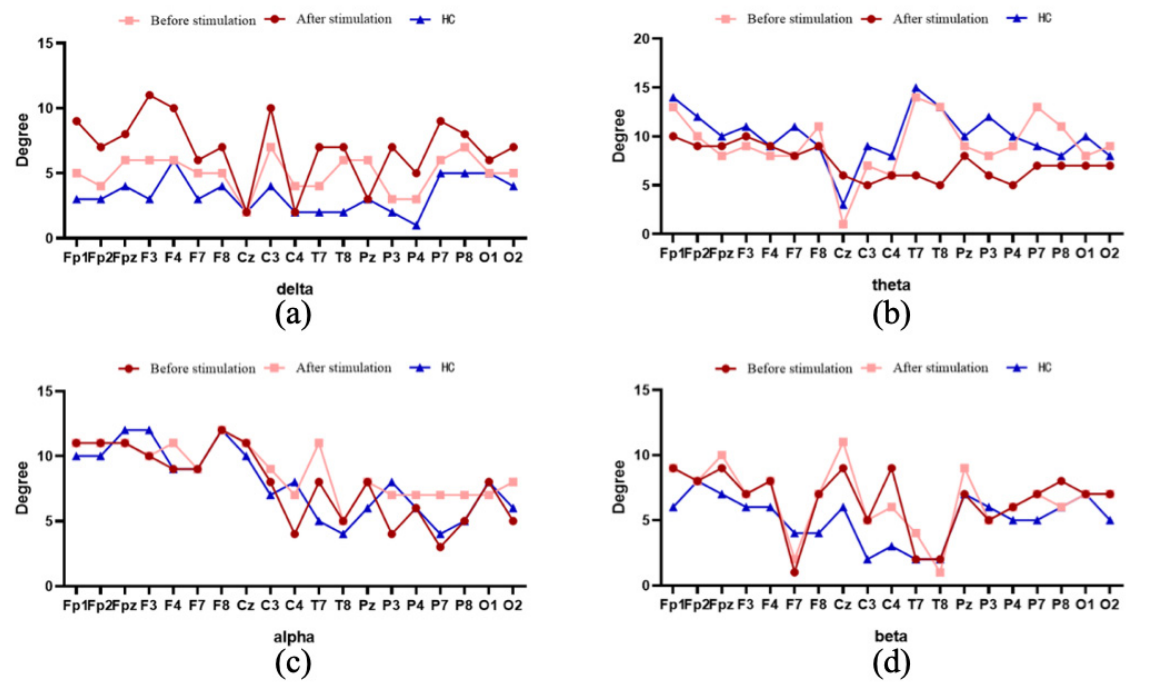
Figure 5. Degree of nodes in EEG functional brain network. ( a ) Delta band; ( b ) theta band; ( c ) alpha band; ( d ) beta band. The horizontal axis represents the channel position, and the vertical axis represents the number of nodes.